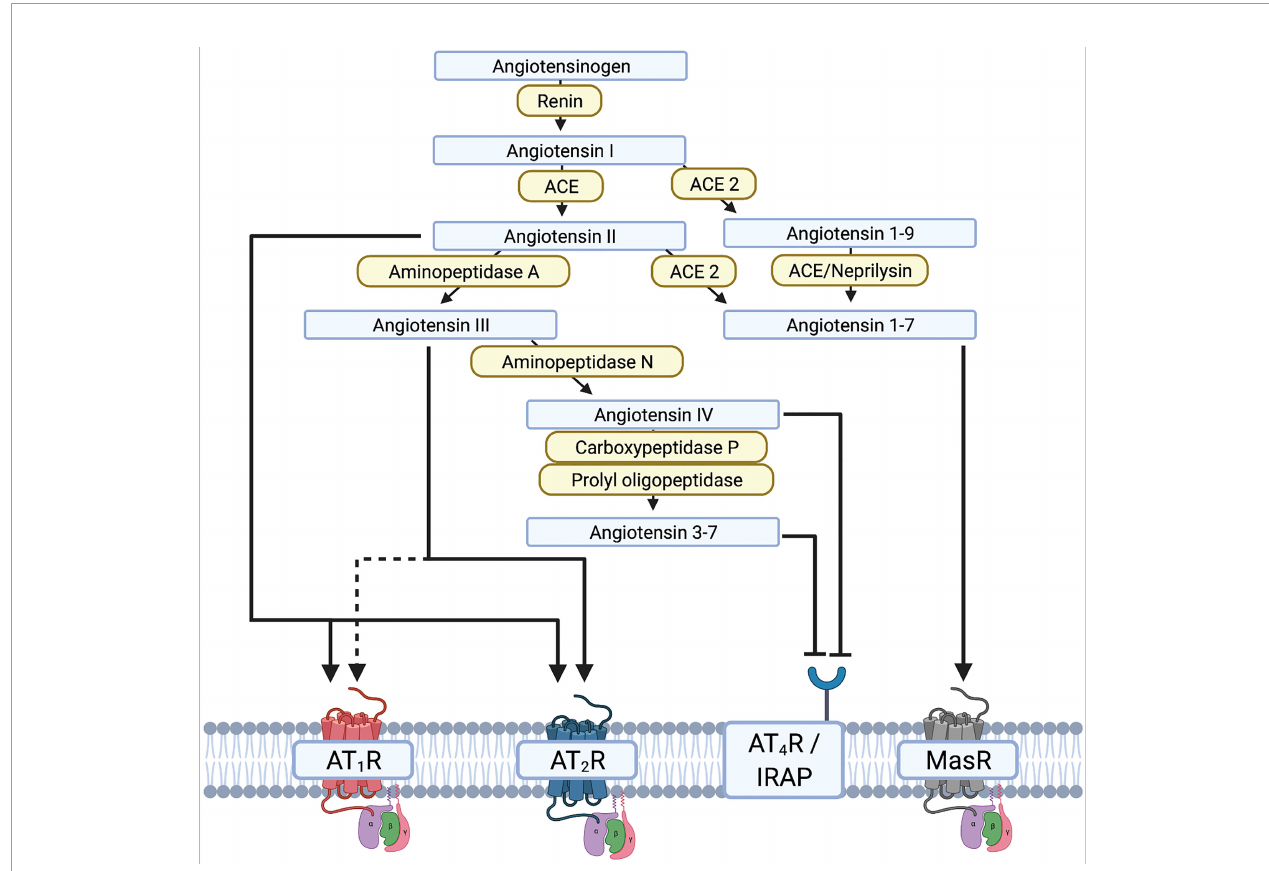
FIGURE 2 | Illustration of the renin-angiotensin system (RAS) and the different interactions of the renin-angiotensin-[aldosterone] system RAAS substrates on receptors. - Created with